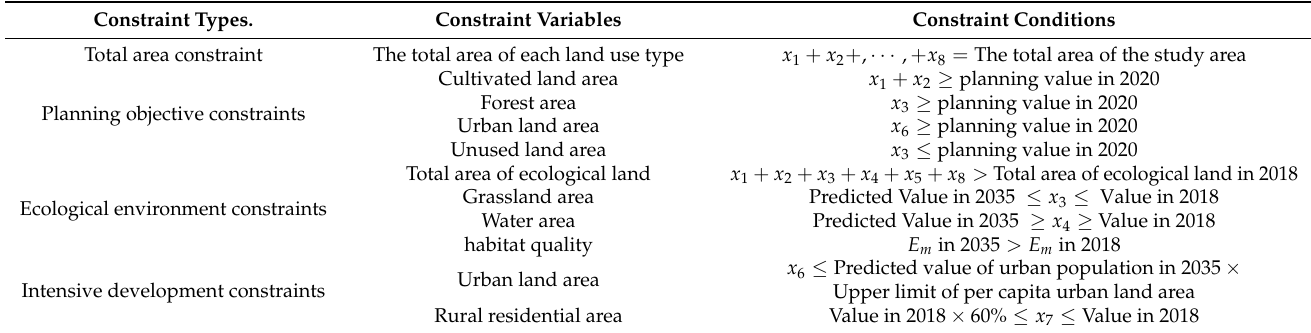
Table 3. The constraint conditions of land use type area